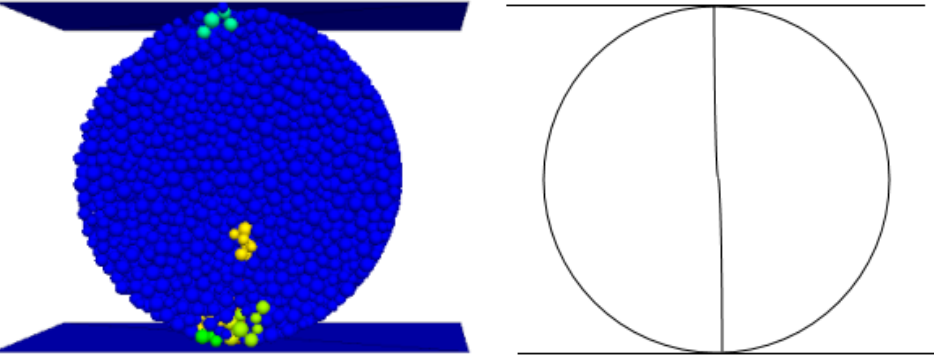
Figure 7. Transjuane Sandstone specimen after splitting failure in Brazil.